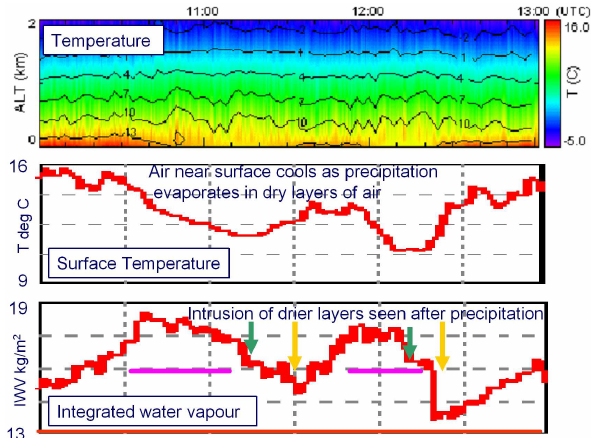
Fig. 10d. Composite weather radar rainfall for the 25 August 2005 at 12:00UTC. The white cross indicates the Linkenholt site. The rain rate/h is indicated by the colour scale on the bottom left. The bulls-eye is centred at the Chilbolton radar with the first and second circles of radius 25 and 50km. Integrated water vapour contours are superimposed in orange at 2kgm − 2 intervals. The position of the cold pools of air close to the surface cooler than 12 ◦ C observed by the automatic weather stations deployed for CSIP are indicated by the white contours filled with light purple. boundary layer at about 900 m with mixing ratios greater than 8 g/kg in the boundary layer falling to values of 6.7 g/kg at about 1.1 km. The fluctuation in the top of the boundary layer in this manner (supported by the limited number of ra- diosondes) is considered typical of the boundary layer in the UK where convection was present in the boundary layer but not developing into deep convection over the site and entrain- ment was taking place into the boundary